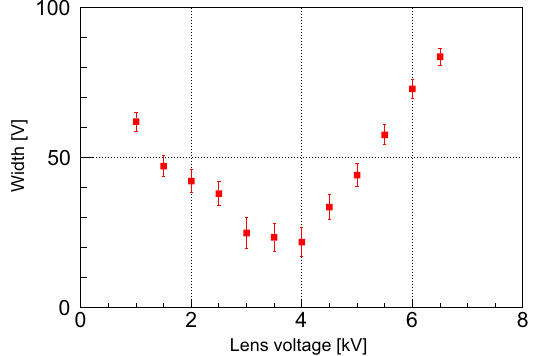
max FIG. 21. Width in the voltage for steering voltage as a function of lens